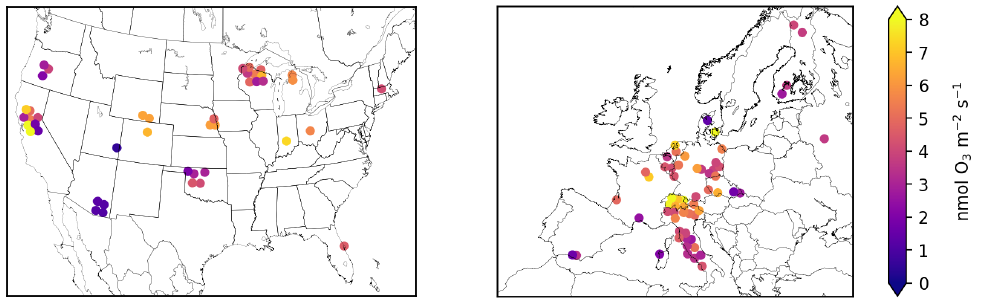
Figure 3. Mean synthetic stomatal O 3 flux ( F syn , Sect. 2.1) during the daytime growing season at FLUXNET2015 sites in the United States s , O 3 and Europe. Symbols of some sites have been moved slightly to reduce overlap and improve